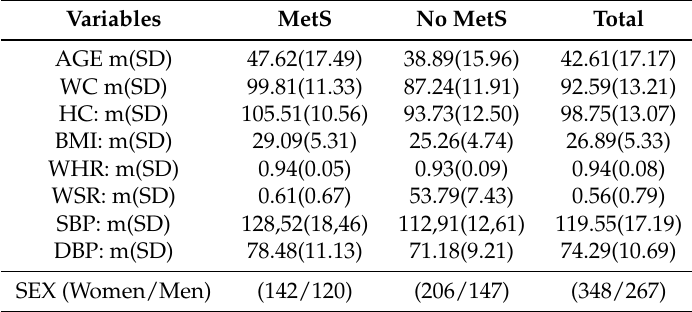
Table 6. Statistic description of the total data of the study variables.